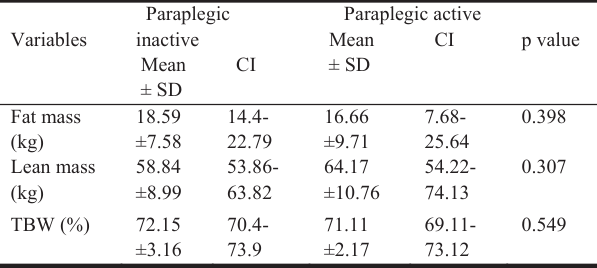
Table 2: BIA results comparing paraplegic groups (active X inactive).